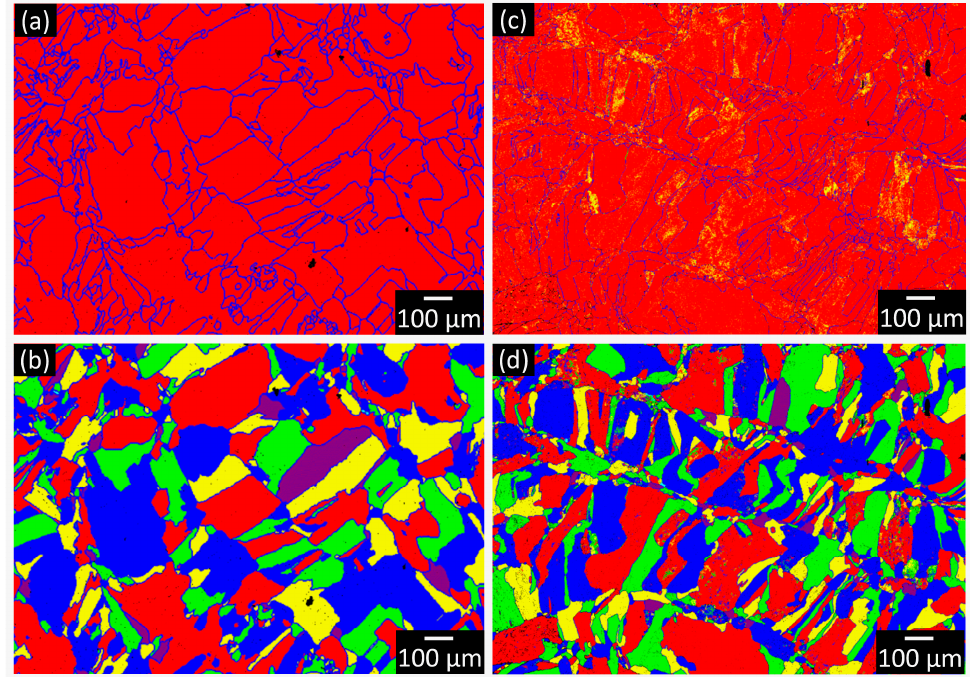
Figure 7. EBSD analysis for: ( a , b ) an unreinforced SLM 316L specimen synthesized at 688 mm/s and ( c , d ) a SLM 316L/CeO 2 composite processed at 488 mm/s. The small yellow particles in ( c ) are CeO 2 .